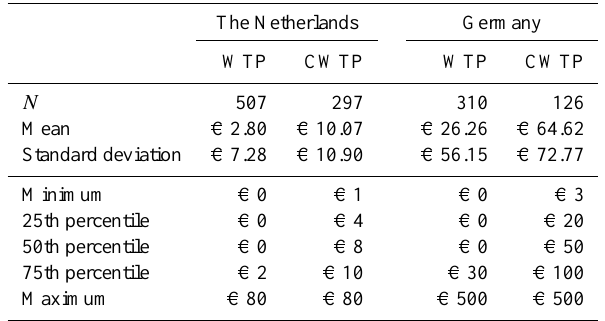
Table 2. Average willingness to pay (WTP) and conditional will- ingness to pay (CWTP) for flood insurance per month of Dutch and German private